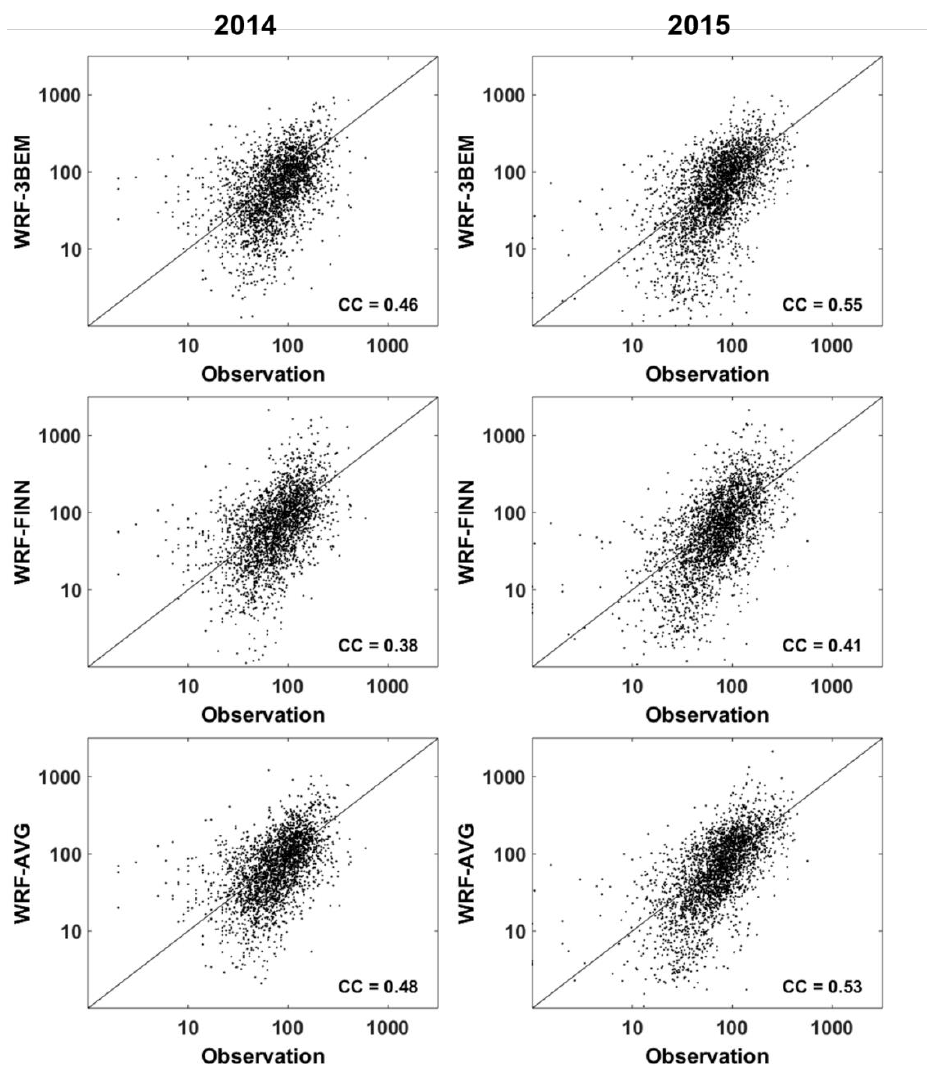
Figure 7. Scatter plots comparing measured hourly average PM10 concentrations ( µ g m − 3 ) and simulations of WRF-3BEM, WRF-FINN, and WRF-AVG for February–April in 2014 and 2015 for all ground stations.